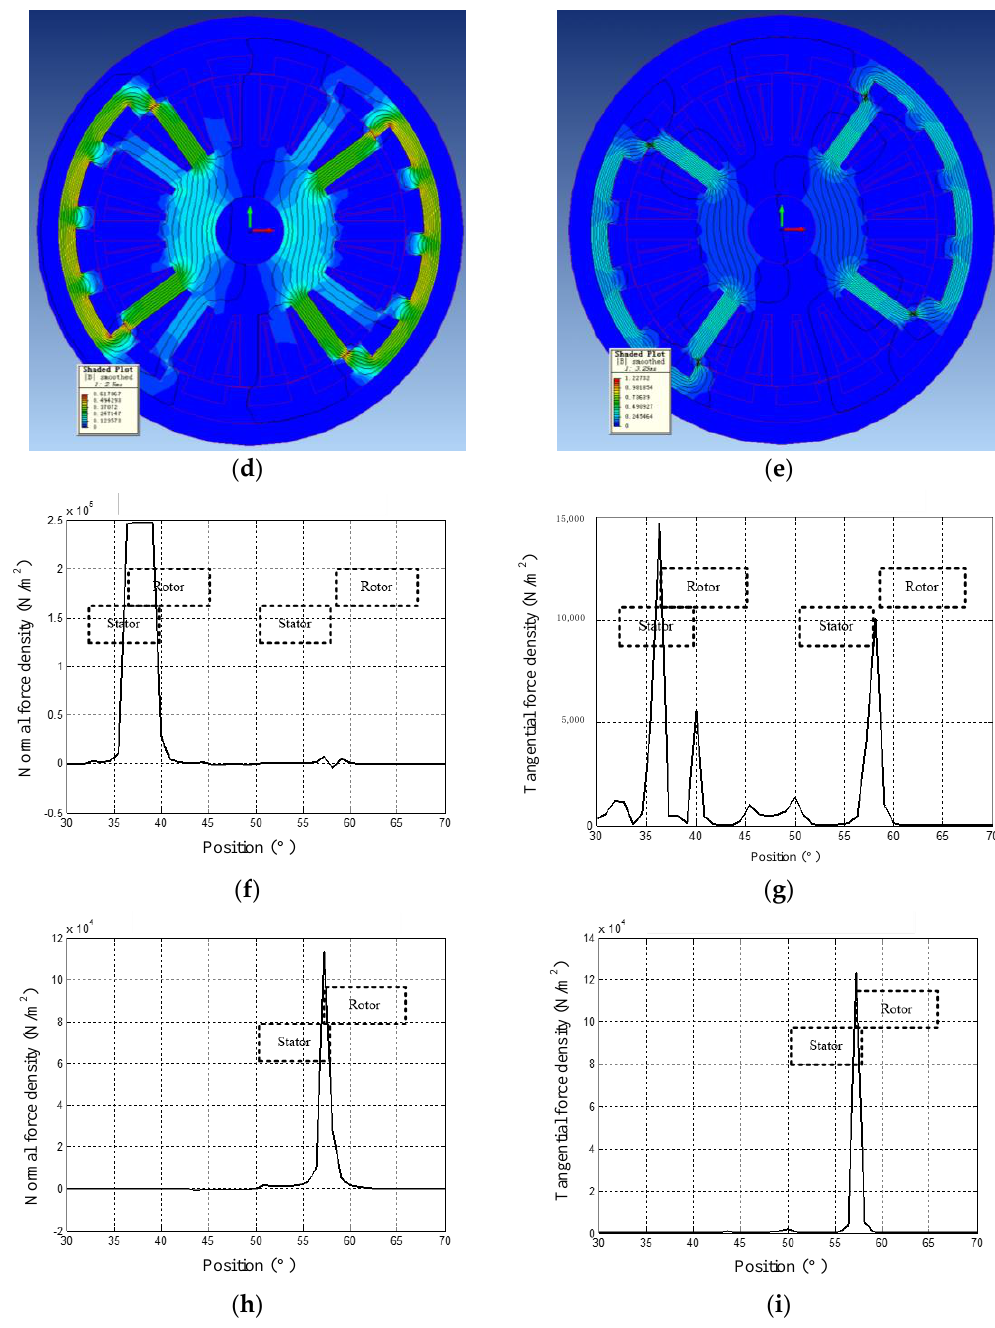
Figure 4. The distribution of magnetic lines of force at different positions and the distribution of electromagnetic force at corresponding positions of OSRM in hybrid excitation mode. ( a ) Distribution of magnetic flux and shaded plot of flux density at position A in hybrid excitation mode, ( b ) distribution of normal force at position A in hybrid excitation mode, ( c ) distribution of tangential force at position A in hybrid excitation mode, ( d ) distribution of magnetic flux and shaded plot of flux density at position B in hybrid excitation mode, ( e ) distribution of magnetic flux and shaded plot of flux density at position C in hybrid excitation mode, ( f ) distribution of normal force at position B in hybrid excitation mode, ( g ) distribution of tangential force at position B in hybrid excitation mode, ( h ) distribution of normal force at position C in hybrid excitation mode, ( i ) distribution of tangential force at position C in hybrid excitation mode.